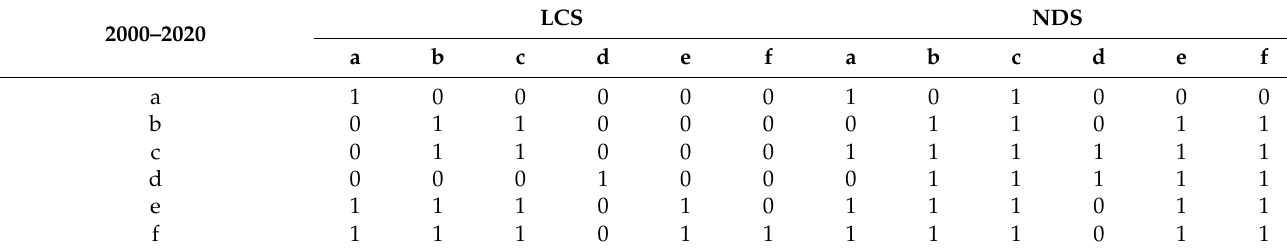
Table A2. Landscape type conversion-cost matrix under two